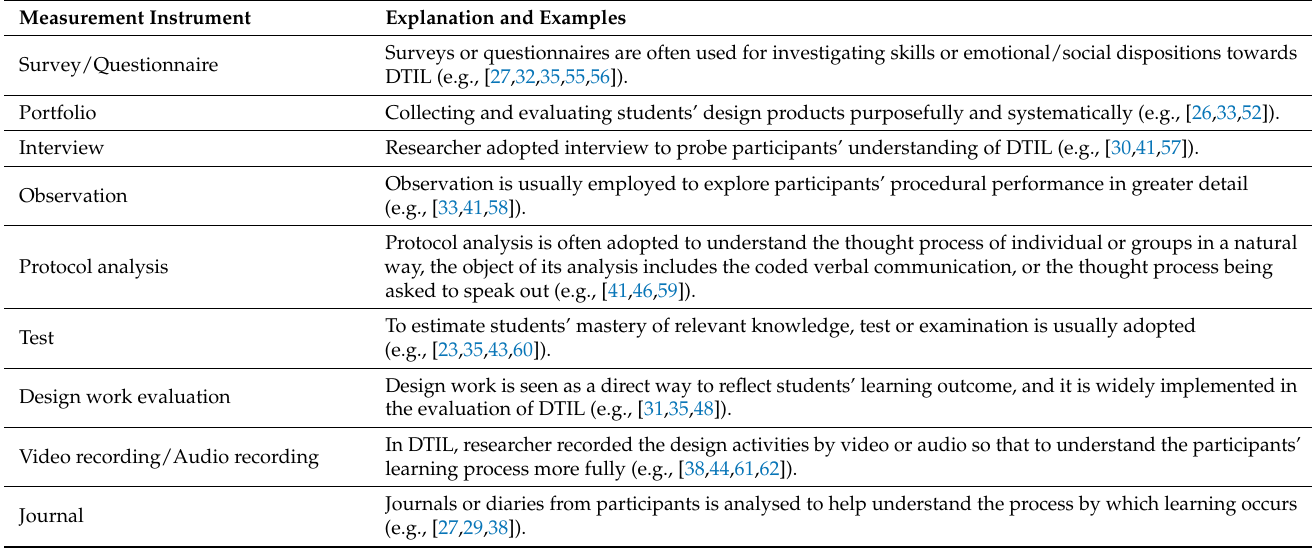
Figure 8. Measurement instruments adopted in the empirical studies. Table 4. Measurement instruments adopted in the empirical studies.